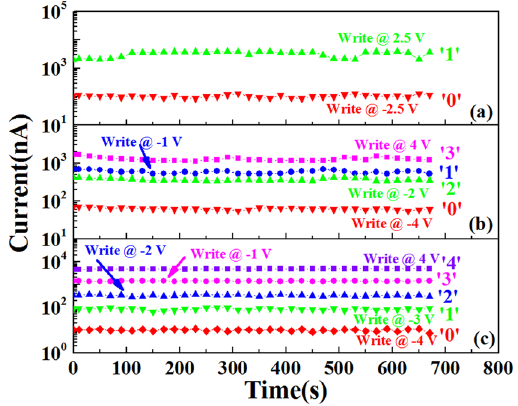
Figure 7. The retention of the Pt/BFO/SiO x /Si memristors. Current as a function of time. ( a ) The device with 2 nm thick BFO film; ( b ) The device with 3.5 nm thick BFO film; ( c ) The device with 5 nm thick BFO